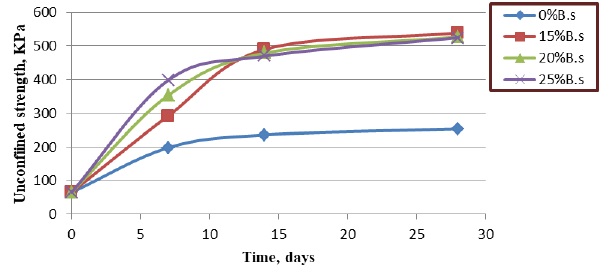
Figure 3: Unconfined compression strength versus time at different concentrations of bacterial solution (B.s)